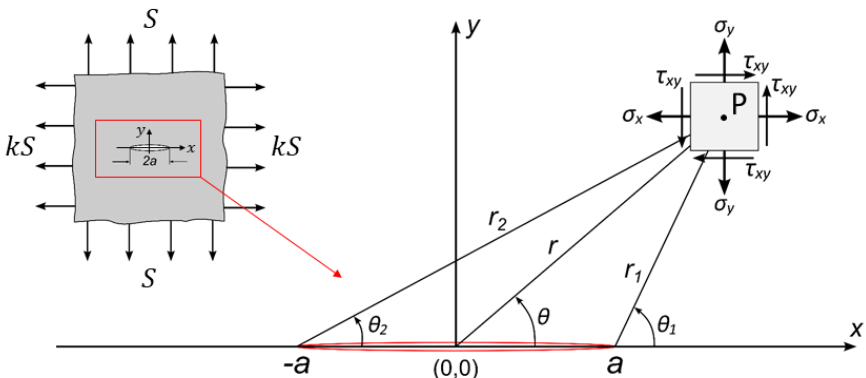
Figure 7. Stress field near a crack in an infinite plate subjected to a general biaxial loading